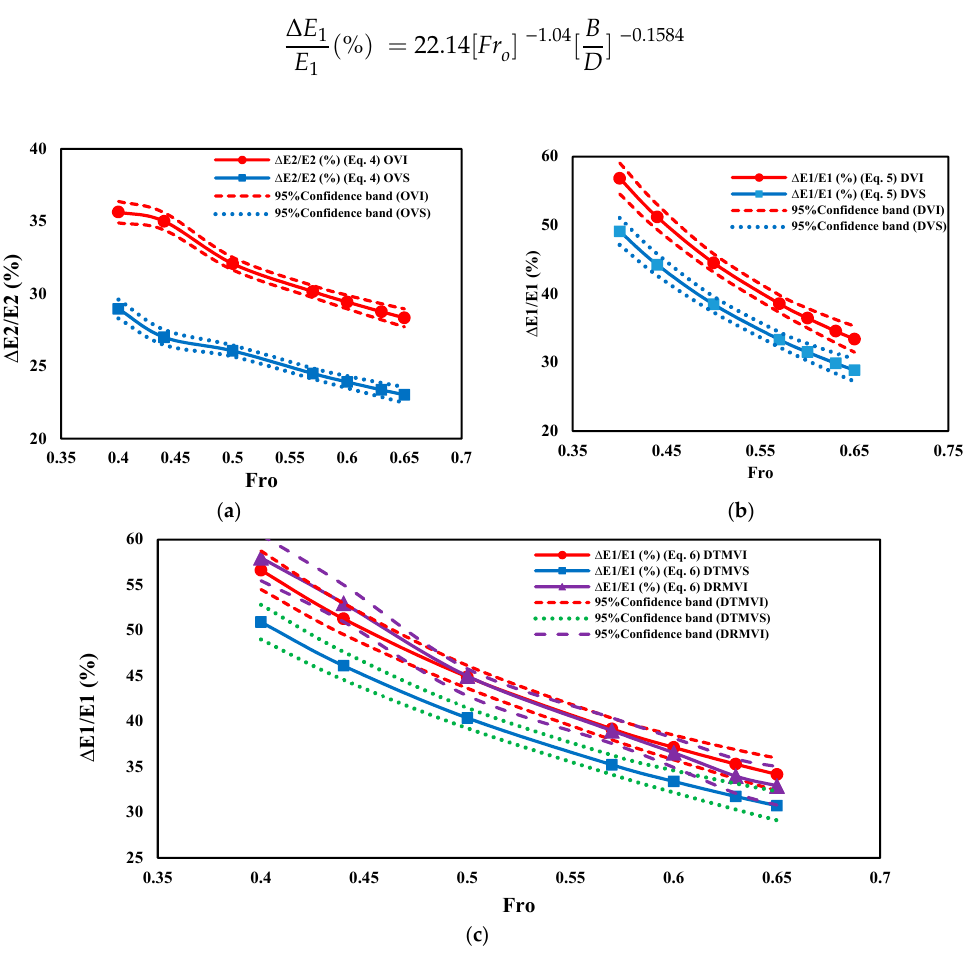
Figure 10. Percentage energy loss for different obstruction types and 95% confidence bands for: ( a ) sparse vegetation (OVS) and intermediate vegetation (OVI), ( b ) DVS and DVI and ( c ) DTMVS, DTMVI and DRMVI.